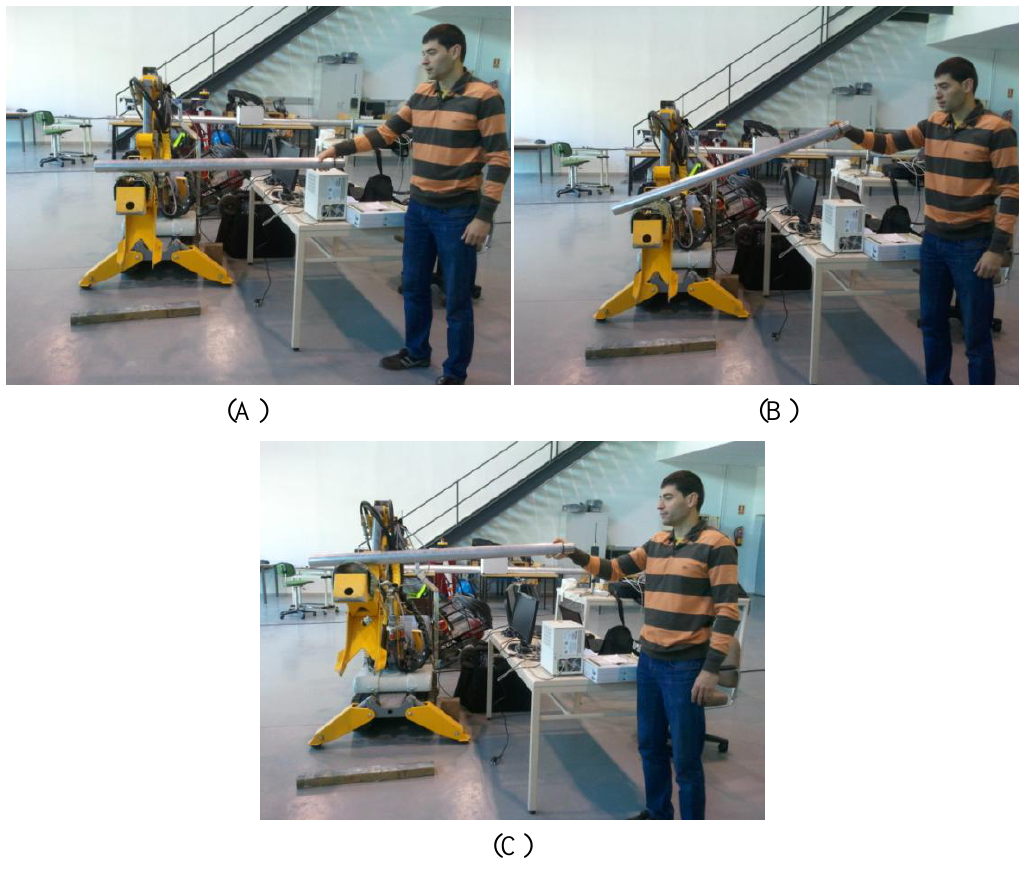
Figure 14. Photographs of the three main steps in the experiment where the robot cooperates with a human.